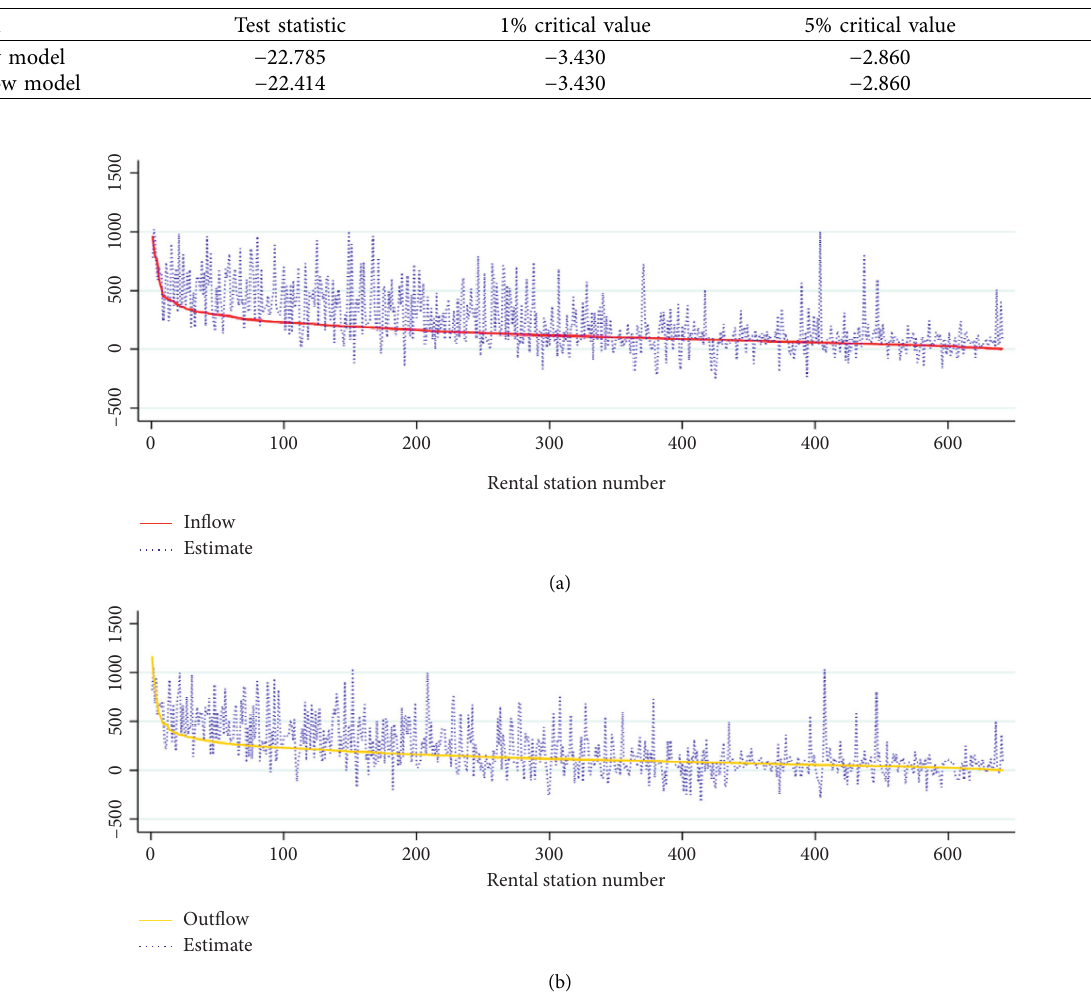
Table 7: ADF test results of the error term.